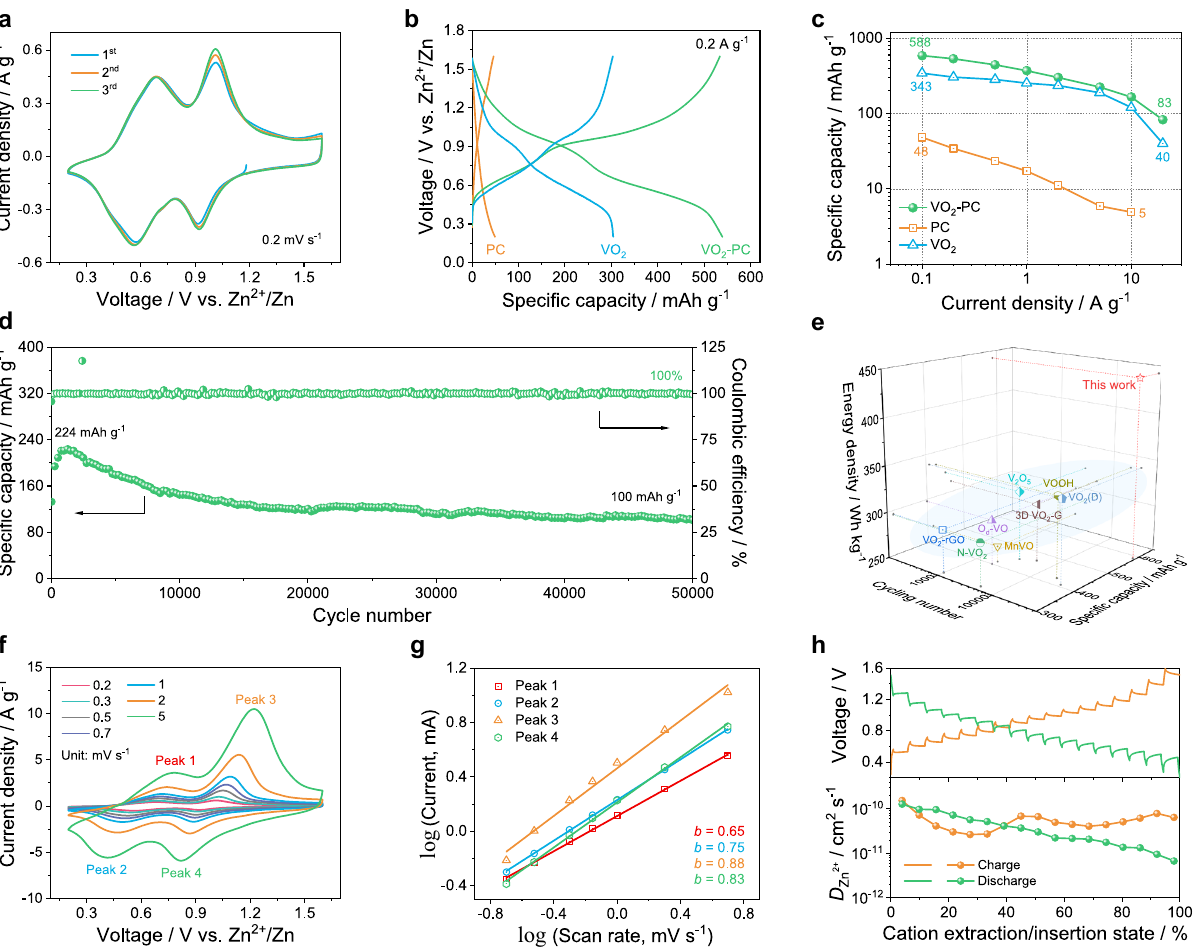
Fig. 4 Electrochemical performance of ZIBs with various electrodes. a CV curves for the initial 3 cycles of VO 2 -PC at 0.2 mV s − 1 . b GCD curves, c Ragone plots, and d cycling stability at 10 A g − 1 . e Comparison of main electrochemical parameters of the VO 2 -PC-based ZIB with other reported devices. f CV curves at various scan rates. g The corresponding log (current) vs. log (scan rate) of each redox peak. h GITT curves and Zn 2 + diffusion coef fi cient at